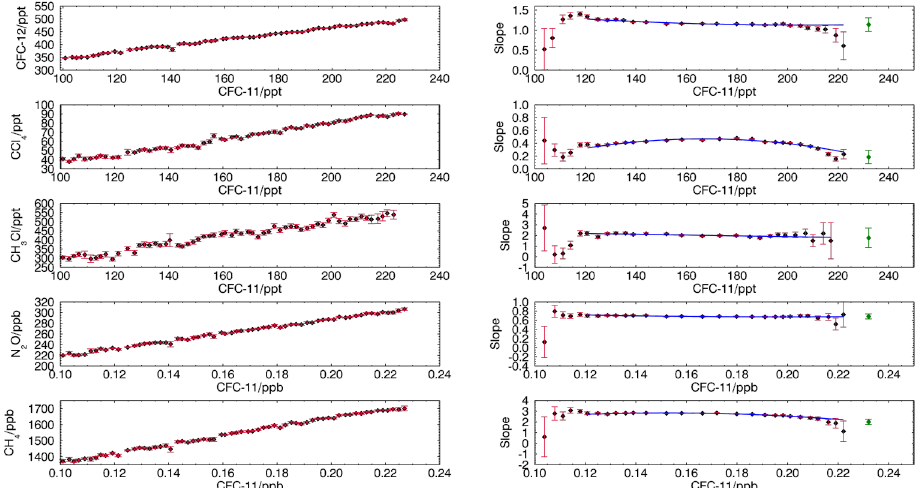
Figure B21 Correlations between the volume mixing ratios of CFC-12, CCl 4 , CH 4 , CH 3 Cl and N 2 O and CFC-11 for the data from the southern hemisphere during the stratospheric winter of 2010. Left panels: The mean correlation profile. Each point represents the mean of the VMR in a window of 2 ppt of CFC- 11. The error on these points is the standard deviation of the data within each 2 ppt window. Right panels: The local slope of data in an 80 ppt of CFC-11 window. The error on the points is the fitting error of this fit. The blue line is a second degree polynomial fit to the local slopes. The green point is the extrapolated slope at the tropopause.